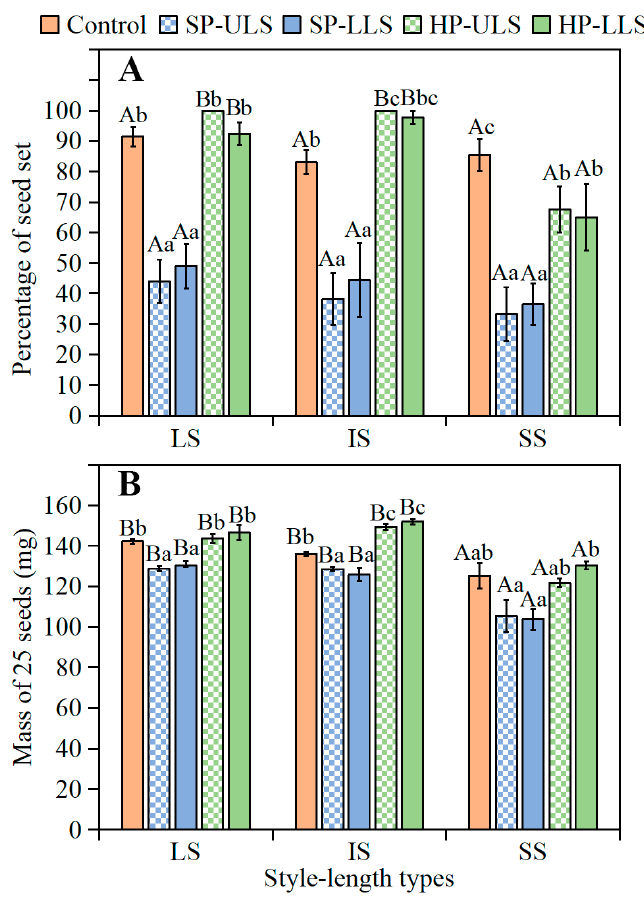
Figure 5. Effect of pollination treatment on flowers with different style lengths on ( A ) seed set and ( B ) seed mass of Ixiolirion songaricum (mean ± 1 s.e.). LS, seeds from flowers with long style; IS, seeds from flowers with intermediate style; SS, seeds from flowers with short style; Control, natural (open) pollination; SP-ULS, self-pollination with pollen from upper-level stamens; SP-LLS, self-pollination with pollen from lower-level stamens; HP-ULS, hand pollination between flowers on different plants with pollen from upper-level stamens; HP-LLS, hand pollination between flowers on different plants with pollen from lower-level stamens. Bars with different uppercase letters (A, B) indicate significant differences among different style lengths in the same treatment of artificial pollination and different lowercase letters (a, b, c) significant differences among different treatments of artificial pollination at the same style length (Tukey’s HSD, p = 0.05).